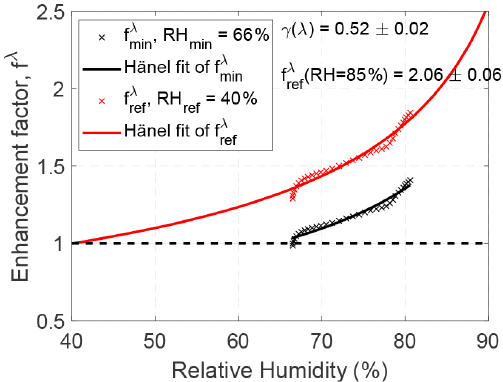
defined starting Figure 3. Example of enhancement factors f λ min at RH min and f λ defined starting at RH ref = 40% of one single ref case (the data are those of Fig. 1: 22 July 2013, at 13:02UTC; λ = 532nm). The calculation of the standard errors associated with γ and f λ is explained in Sect. ref